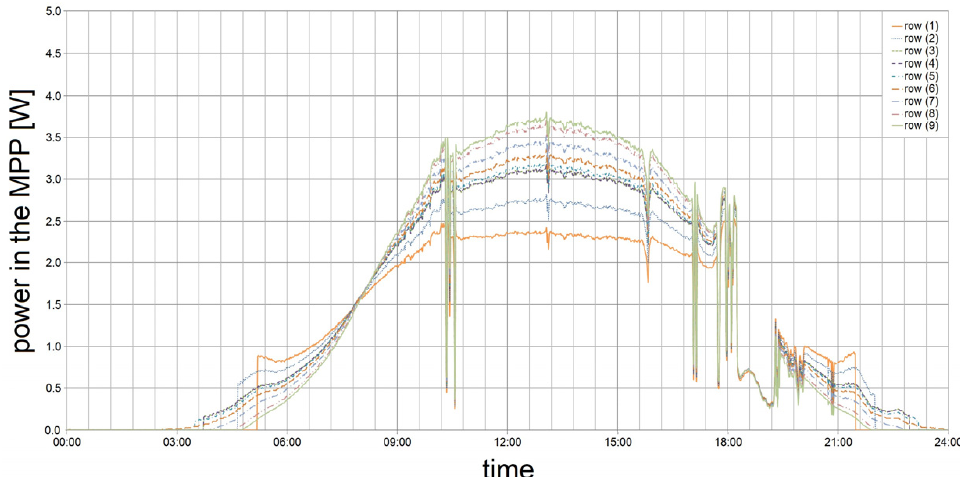
Figure 24. Simulated power at MPP ( P mpp ) for ψ = 0°.